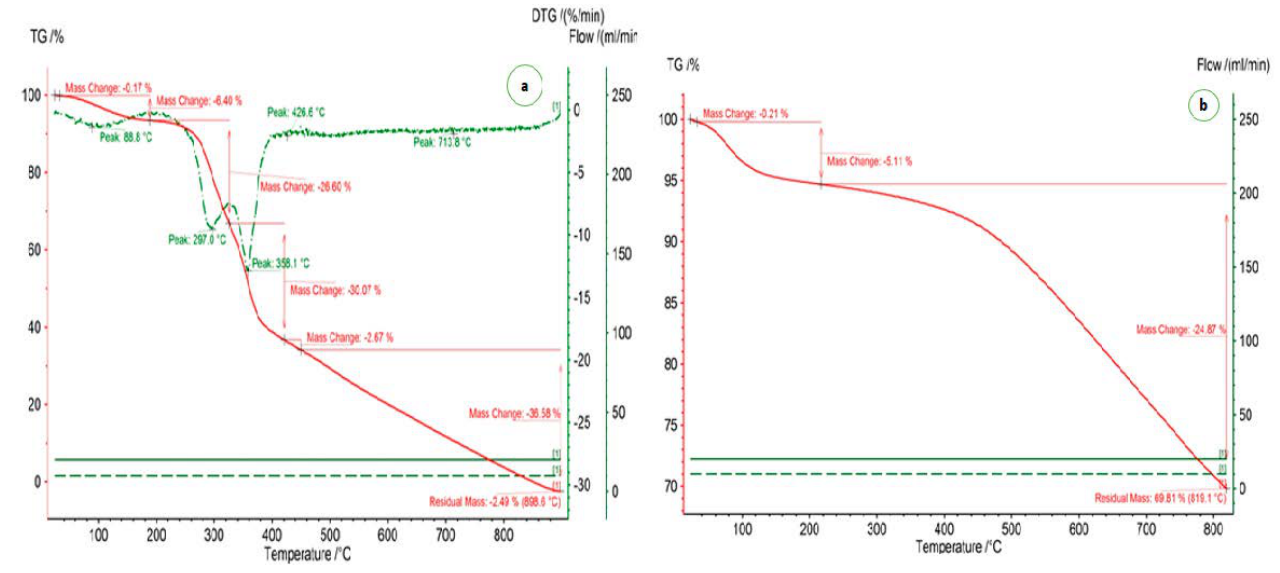
Figure 4. Thermogravimetric analysis of ( a ) date stone biomass and ( b ) porous AC.